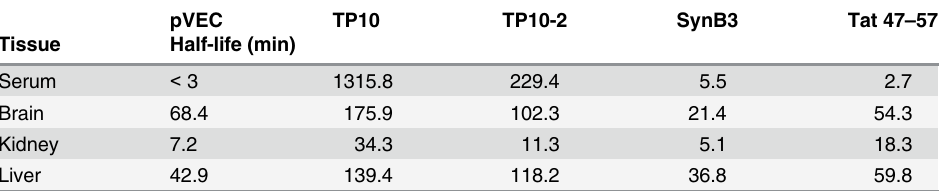
Table 4. Overview of the in vitro metabolic stability results of the five investigated